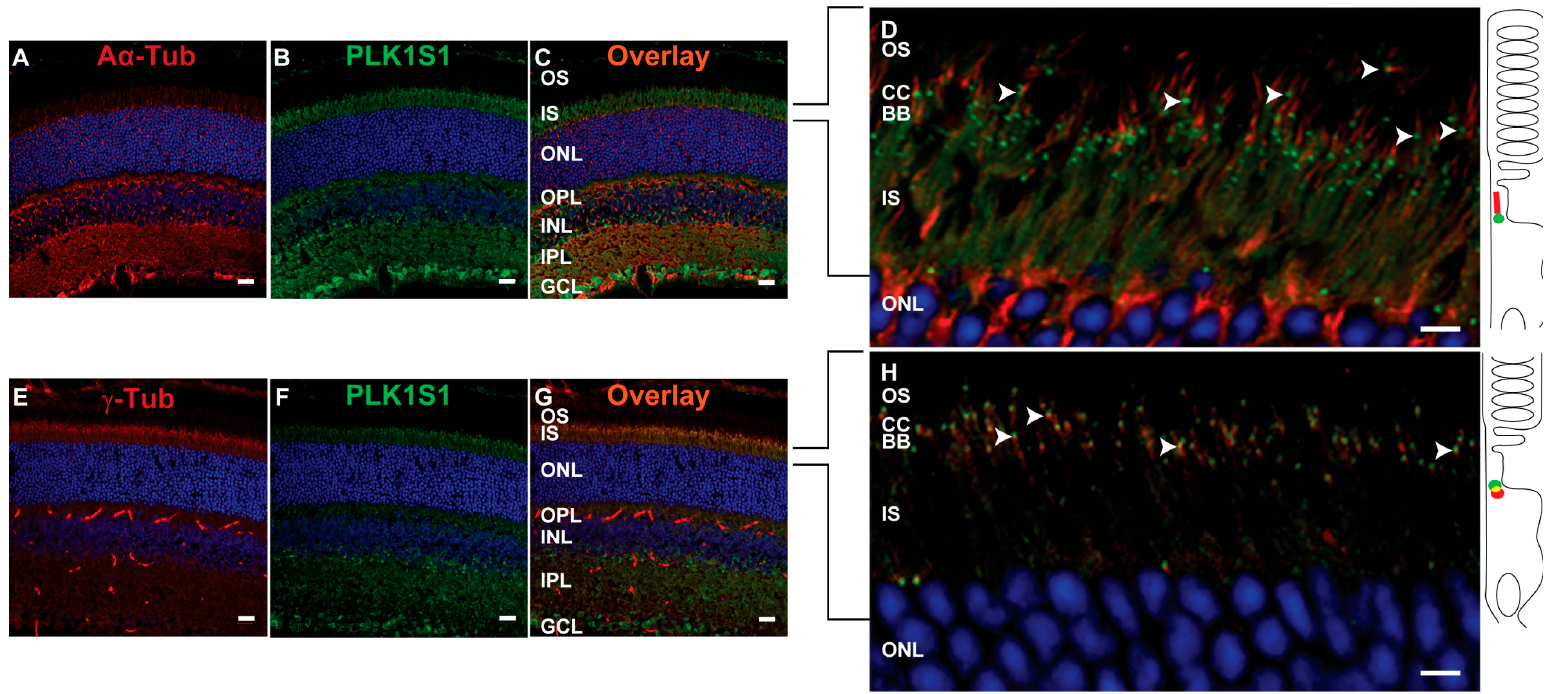
Figure 6. Immunolocalization of PLK1S1 in adult mouse retina. ( A , B ) Mouse retinal sections were stained with anti-acetylated α -tubulin (A α -Tub) and anti-mouse PLK1S1 antibodies. ( C ) Merged images show that PLK1S1 is localized between the outer segments (OS) and inner segments (IS), in the outer plexiform layer (OPL), in the inner plexiform layer (IPL) and in the ganglion cell layer (GCL). ( D ) A close-up image of the OS and IS revealed PLK1S1 (arrow heads) staining in close vicinity to the base of acetylated α -tubulin (A α -Tub) stripe, which resembles the connecting cilium. ( E , F ) Mouse retinal sections were stained with γ -tubulin ( γ -Tub) and anti-mouse PLK1S1 antibodies. ( G ) Merged images show partial co-localization at the level of adjacent centriole of the basal body in photoreceptor cells. ( H ) A close-up image reveals a partial overlap (yellow) between PLK1S1 (arrow heads) and γ -tubulin. Nuclei are stained in DAPI (blue). Scale bar represents 20 µ m ( A – C , E – G ) and 5 µ m ( D , H ). α : alpha, CC: connecting cilium, γ : gamma, BB: basal body, ONL: outer nuclear layer. At the right of the close-up figures, a schematic drawing is depicted aiming to summarize the localization of the acetylated α -tubulin staining (red) and PLK1S1 (green) (upper drawing) and γ -tubulin (red) and PLK1S1 (green) (lower drawing).